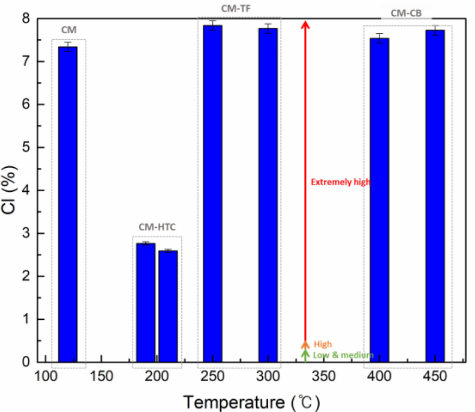
Figure 6. Chlorine content in the cattle manure, hydrochar, torrefied char, and